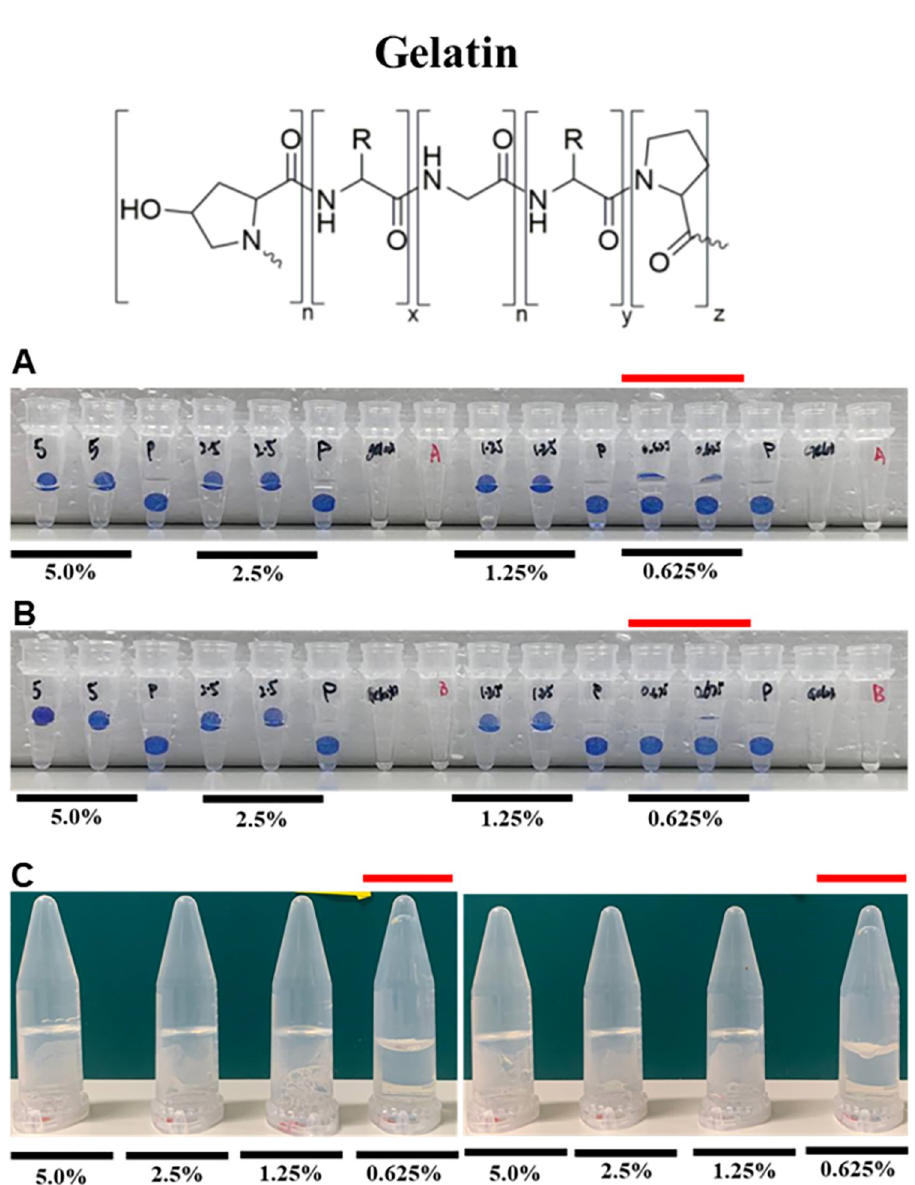
Fig 2. Determining the minimum gelling concentration of gelatin via the floating sphere and inversion assays. Representation of gelation results of gelatin in (a) Thermocycler–Floating Sphere Assay; (b) Water bath–Floating Sphere Assay and (c) Water bath–Inversion Assay. Red line indicates the concentrations below the critical gelling concentration. A minimum of three biological replicates was performed. Results from two additional replicates are presented in S2 Fig.